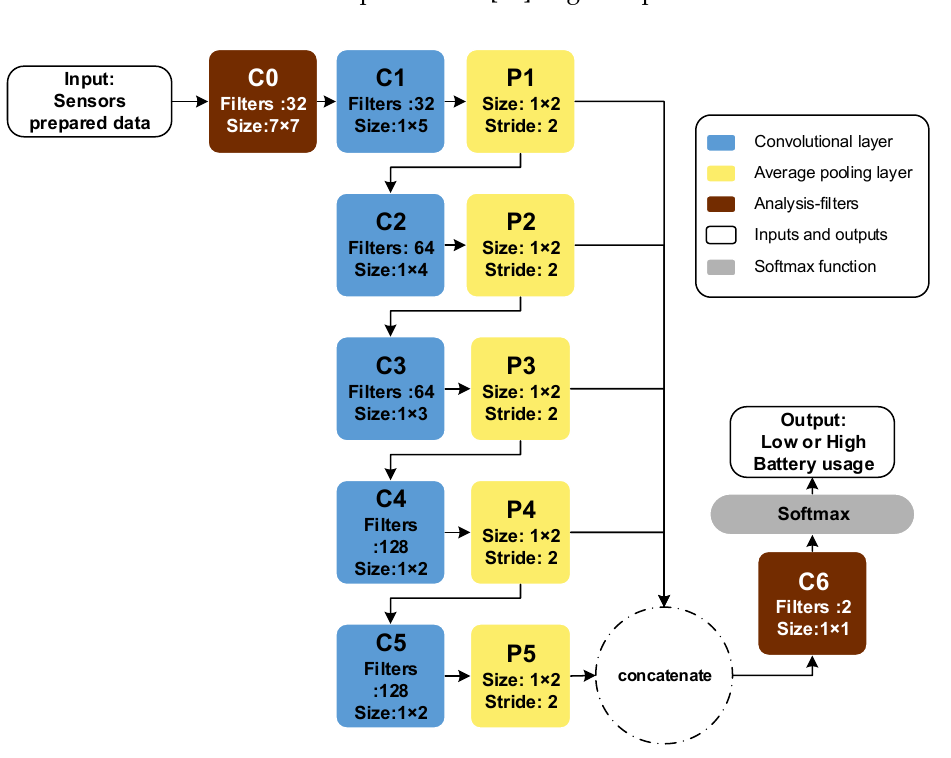
Figure 2. Structure of the fully convolutional neural network (FCNN) model for battery consumption analysis. Convolutional layers are marked with “C” and pooling layers are marked with “P”. Two convolutional layers (C0, C6) are specialized in filtering for analysis. The outputs of the pooling layer are concatenated and fed into the sixth convolution layer to prepare data for softmax function